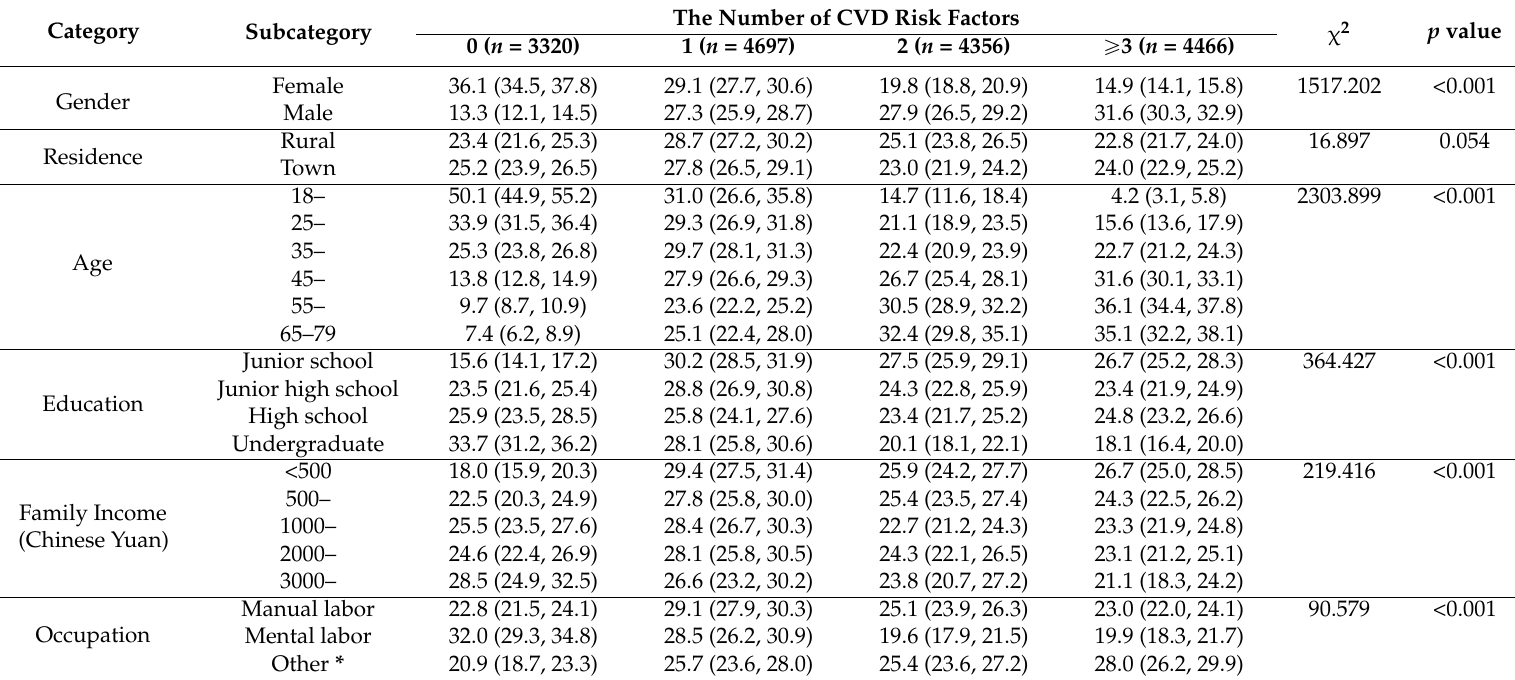
Table 3. Prevalences with the 5 CVD risk